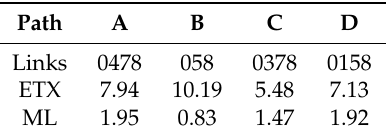
Table 1. Metric values for possible Paths from Nodes 0–8. Path A B